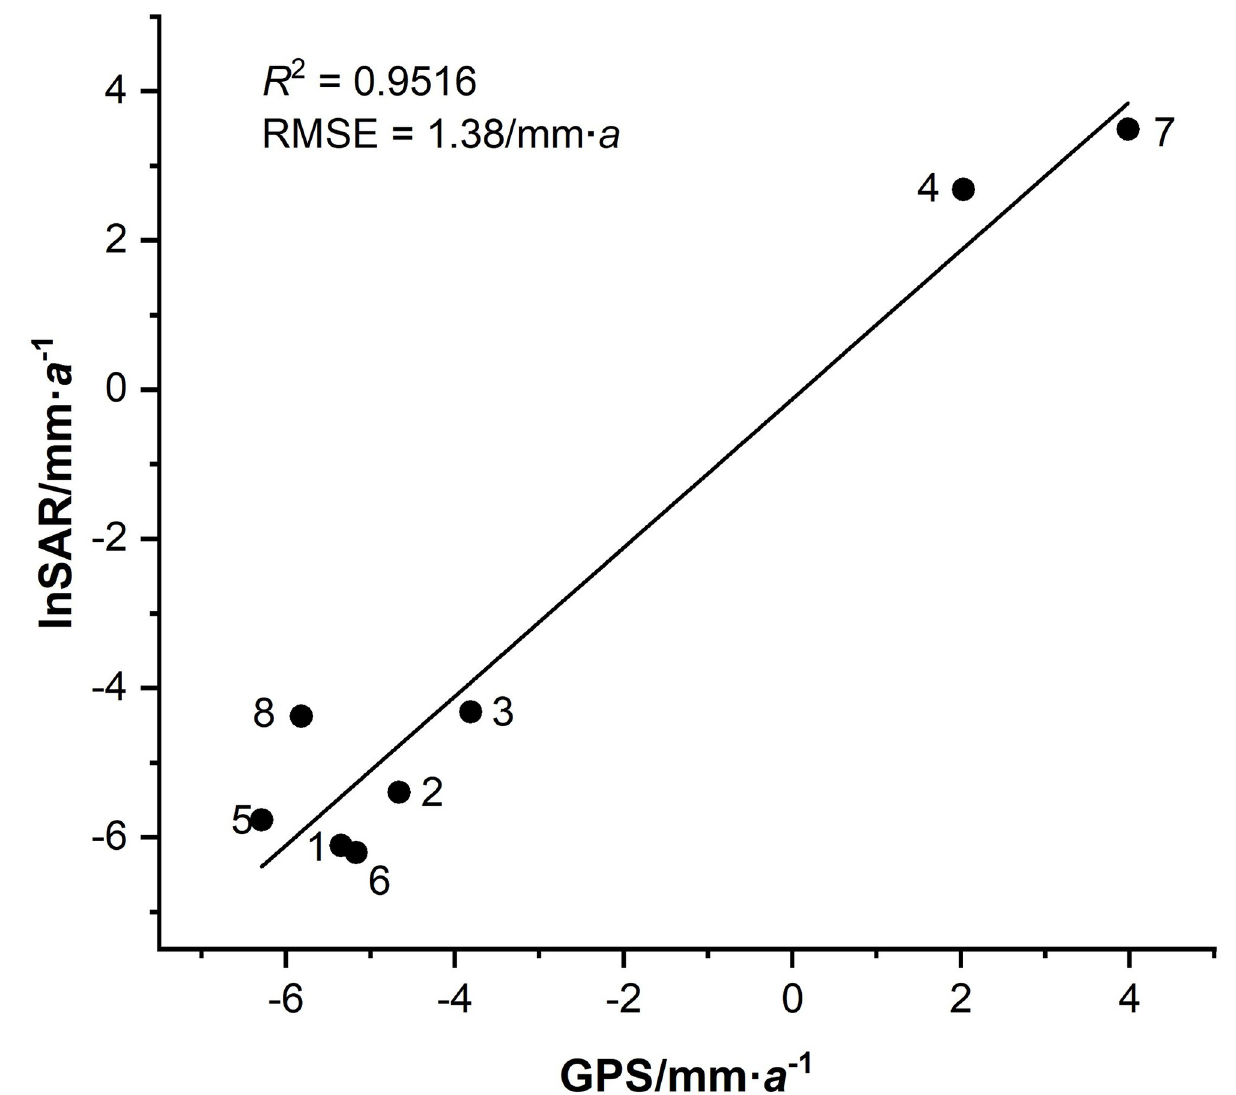
Fig 8. Comparison between time series of InSAR processing results and GPS